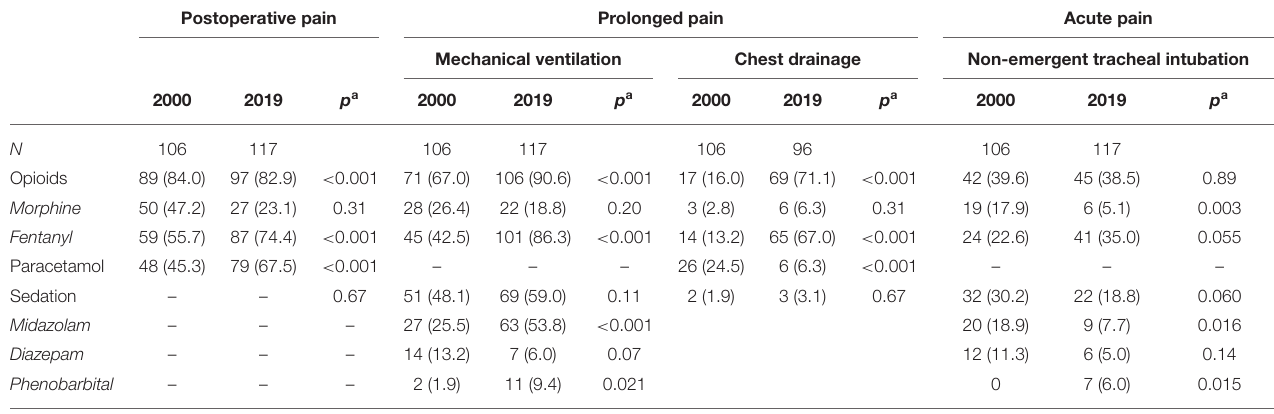
TABLE 3 | Number (percentage) of physicians using certain analgesics and sedatives postoperatively and during specific bedside procedures.